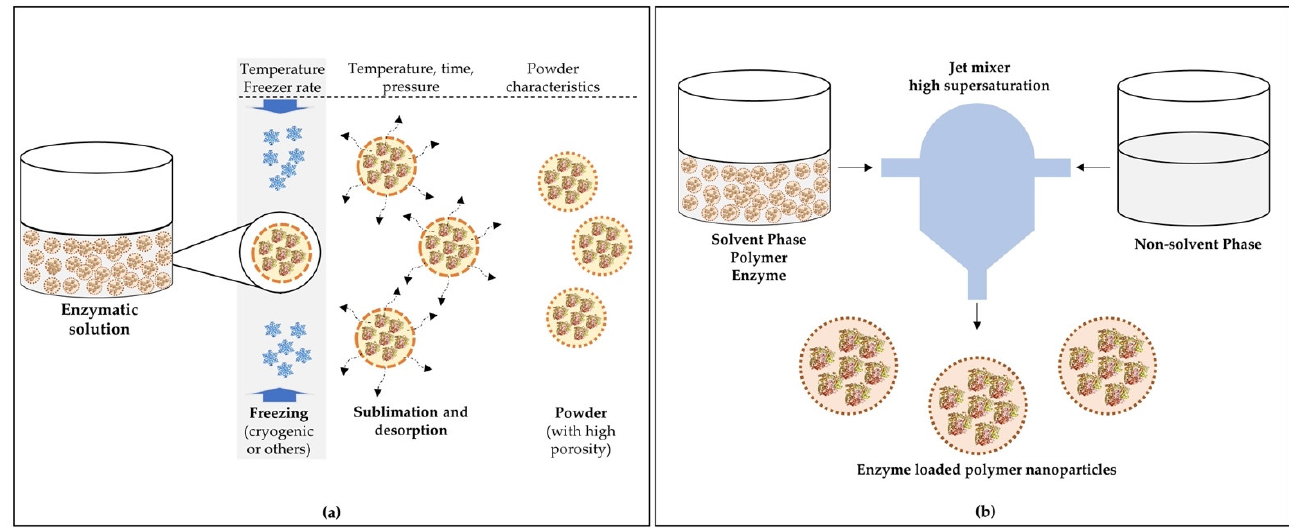
Figure 2. Schemes of capsule production loaded with enzymes by ( a ) a freeze-drying process and ( b ) the flash nanoprecipitation method. Adapted from Vishali et al. [175] and Martínez Rivas et al. [176].